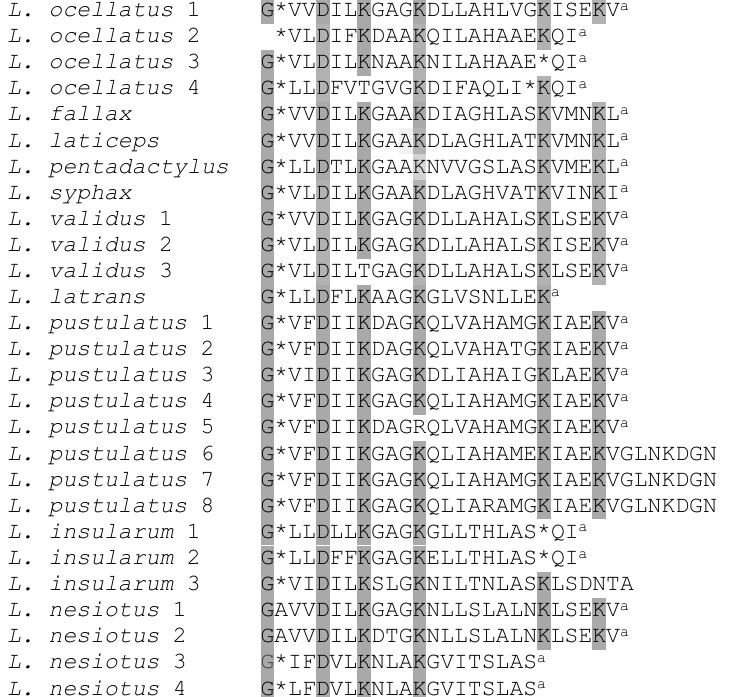
Figure 5. A phylogenetic tree generated using the neighbor-joining method with Poisson correction based upon the primary structures of the ocellatin peptides isolated from frogs belonging to the genus Leptodactylus that are shown in Figure 4.